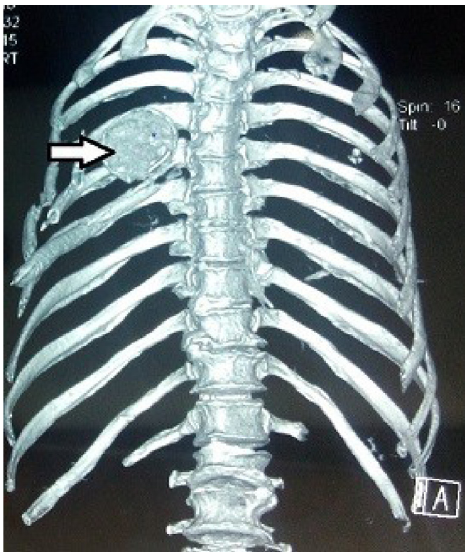
Figure 3. 3D reconstruction CT showing right sided intrathoracic humeral head with fractured ribs on ipsilateral side.